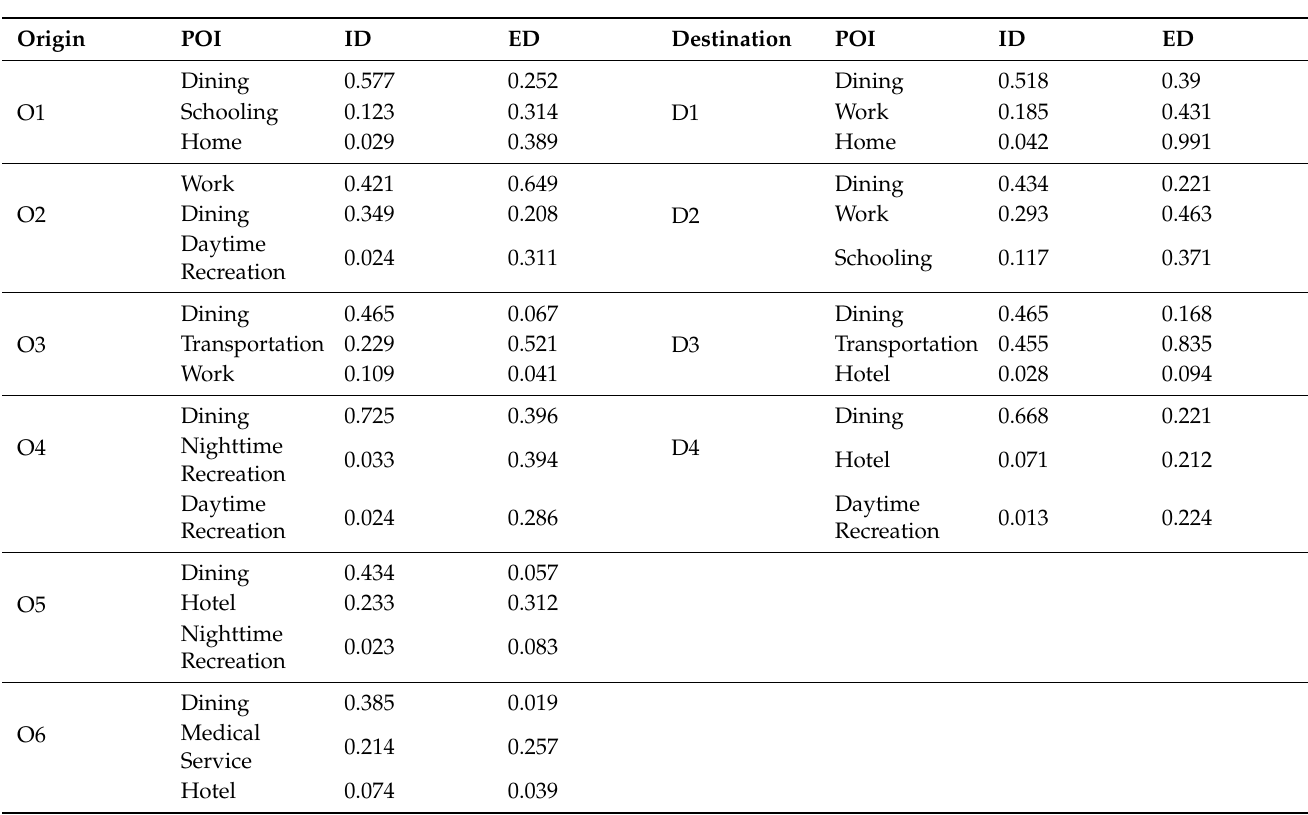
Table 3. Overall POI density and